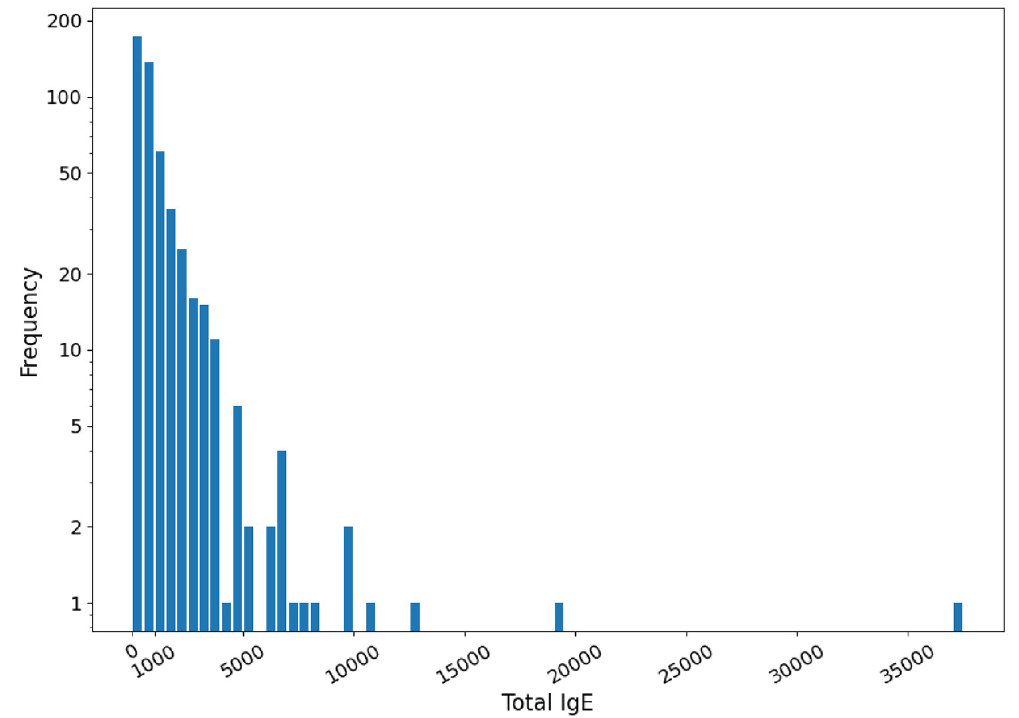
Fig 1. Distribution of total IgE values over the selected patient